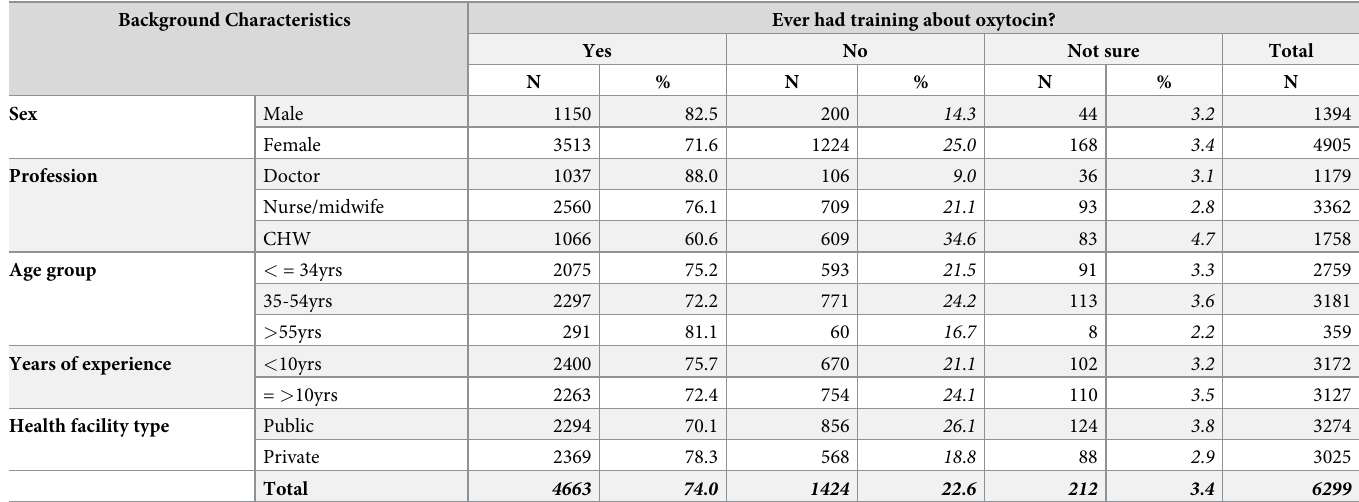
Table 2. Respondents’ assessment of training about